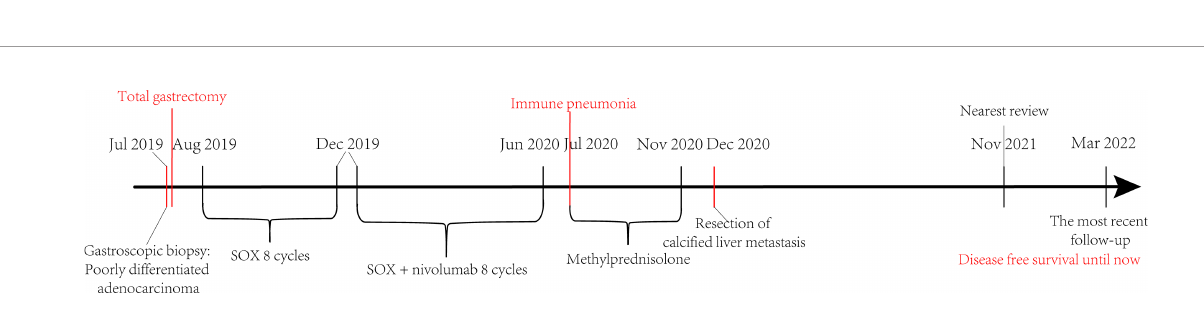
FIGURE 2 | A surgical intervention was implemented to remove the calci fi ed liver metastasis (E) when pneumonia resolved, and PET (A – D) and CT scans (F) demonstrated that liver metastasis